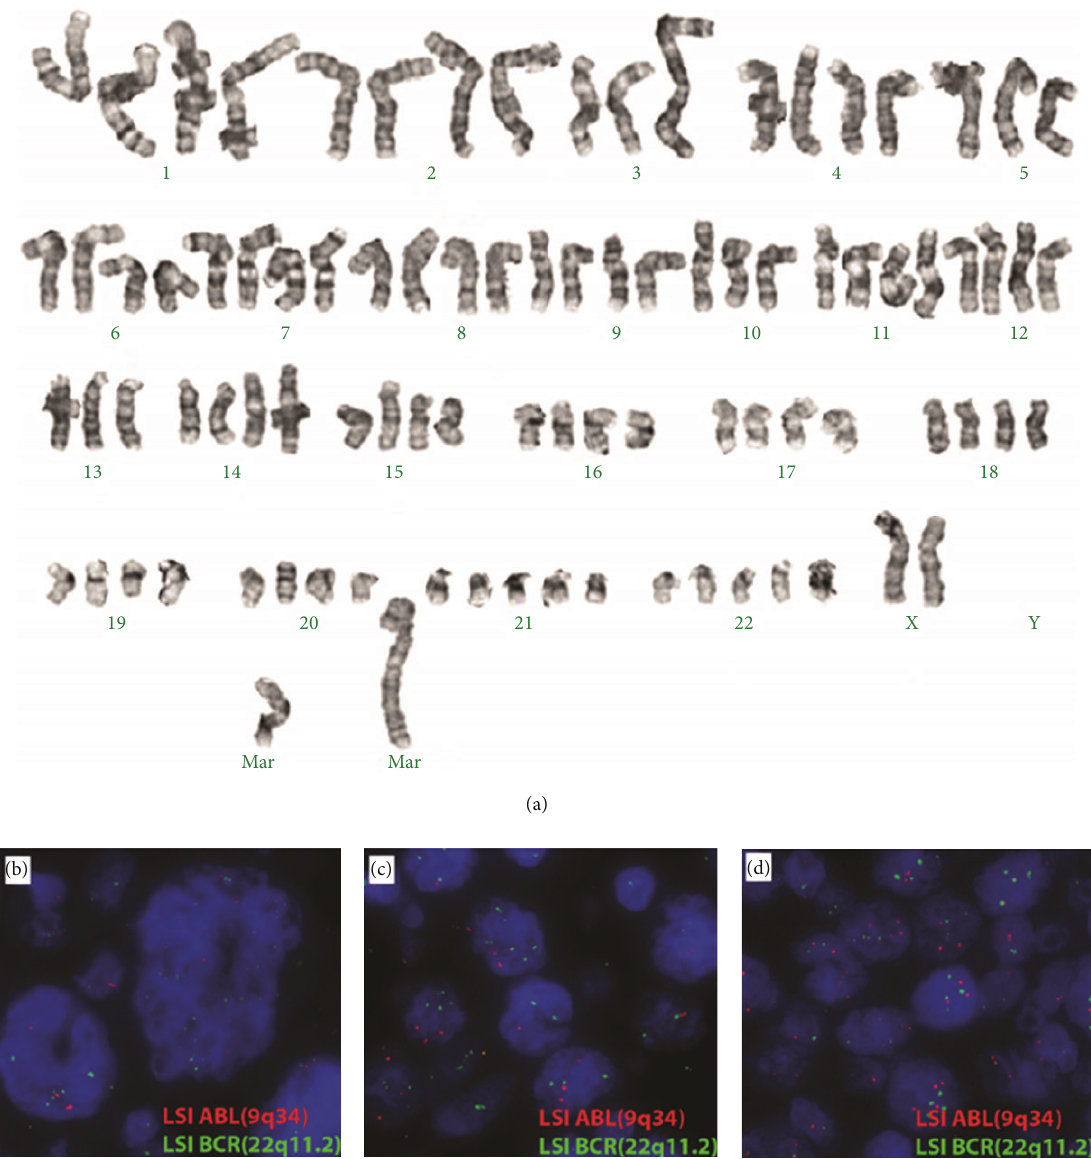
Figure 3: Conventional cytogenetics and FISH analysis of the lymphoma. (a) Representative karyotype showing complex numerical and structural abnormalities. (b) and (c) FISH analysis using LSI ABL (9q34, red) and LSI BCR (22q11.2, green) dual color probes shows approximately 3–8 signals for chromosome 9 (red) and chromosome 22 (green) in anaplastic large cell lymphoma-like area. (d) FISH analysis using the same probes shows approximately 4 signals for chromosome 9 (red) and chromosome 22 (green) in conventional diffuse large B-cell lymphoma